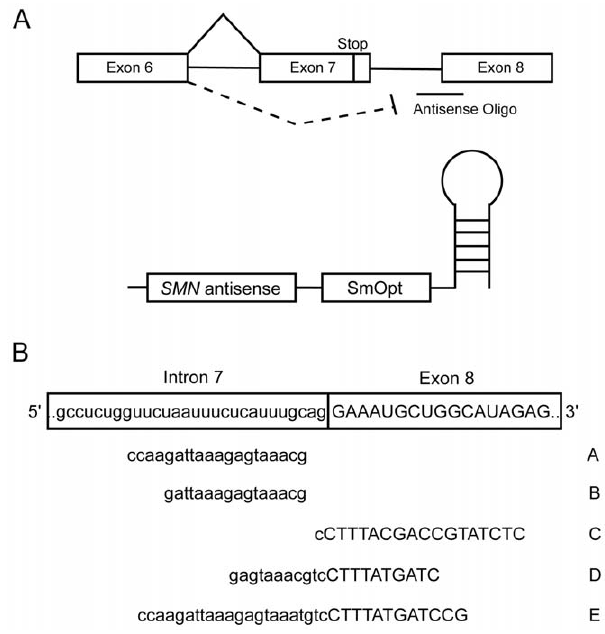
Figure 1. Antisense U7 snRNA strategy and selection of antisense oligonucleotides for Adenovirus delivery. (A) The modified U7 snRNA contains a sequence complementary to the 3 9 splice site of SMN exon 8. In addition, the wild-type murine U7 Sm binding sequence was replaced with the human consensus Sm binding sequence (SmOpt) to inactivate target cleavage [15]. (B) Nucleotide sequence and target location of the five different antisense oligonu- cleotides chosen for Adv-5 vector-derived delivery.